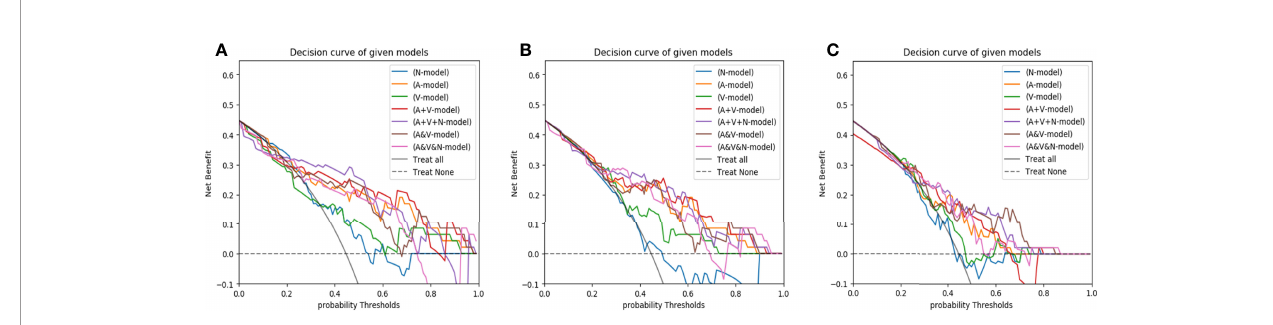
FIGURE 6 | The decision curves of radiomics models developed by three classi fi ers ( A , LR; B , SVM; C , RF) based on different CT-phase images in the test cohort. N-model: NCP model; A-model: AP model; V-model: VP model; A+V-model: AP+VP model; A+V+N-model: AP+VP+NCP model; A&V-model: AP&VP model; A&V&N-model: AP&VP&NCP-model.